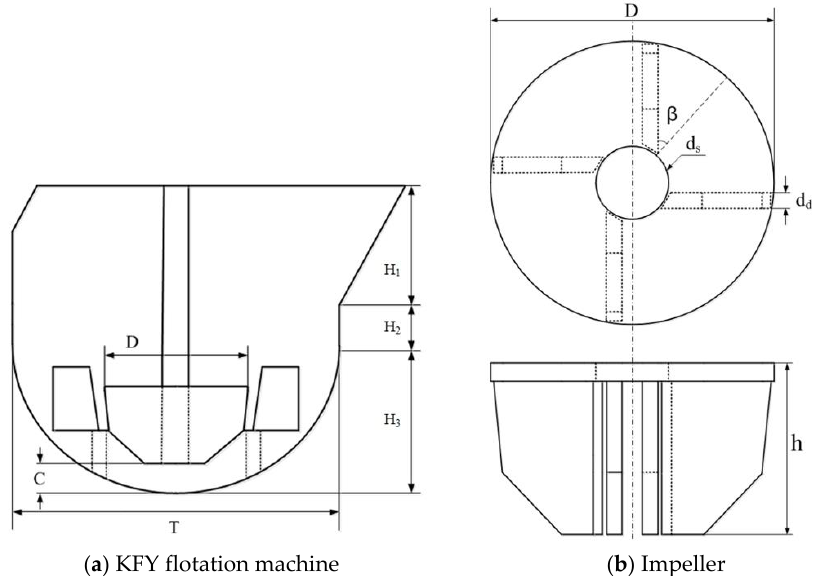
Figure 2. Schematics of the KYF (Kuang Yuan Flotation) flotation machine and impeller with relevant dimensional details.